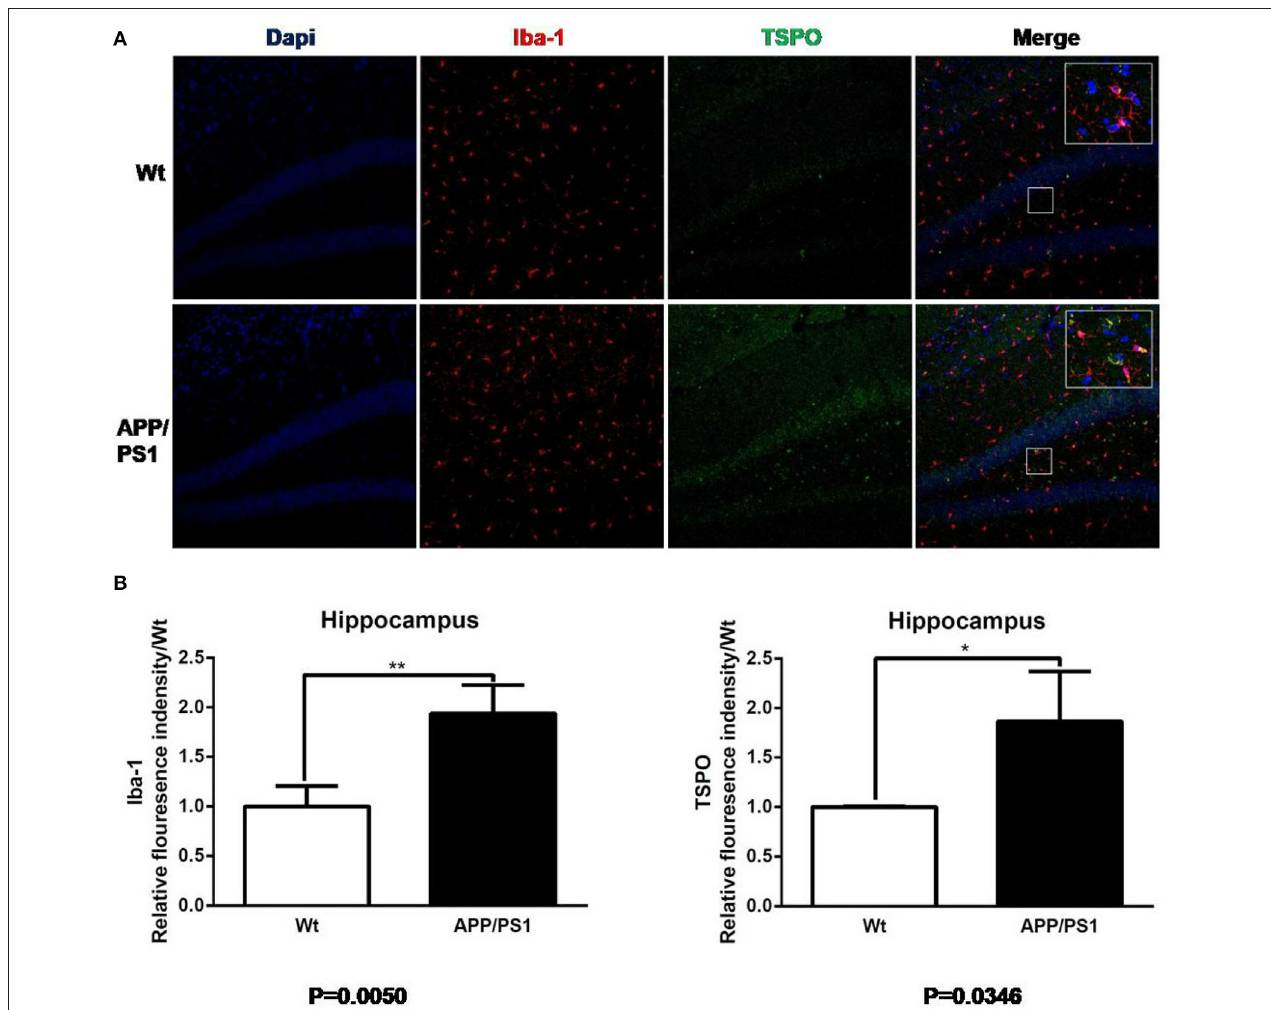
FIGURE 8 | Iba-1 and TSPO staining in hippocampus. (A) Representative images from 15- to 16-months-old APP/PS1 and Wt mice, Scale bar = 50 um, magnification, × 20. (B) Quantitation of TSPO and Iba-1 relative fluorescence intensity in the hippocampus of APP/PS1 mice relative to Wt mice. * p < 0.05, ** p <